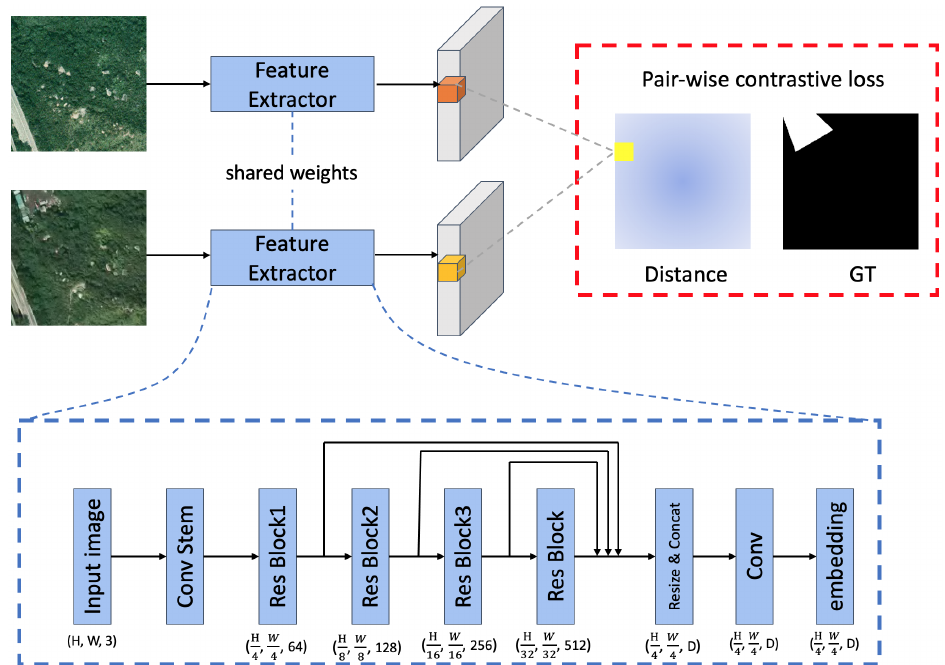
Figure 2. The structure of the proposed baseline networks with contrastive loss. With embeddings from pair-wise/triple-wise images, we compute different loss functions on